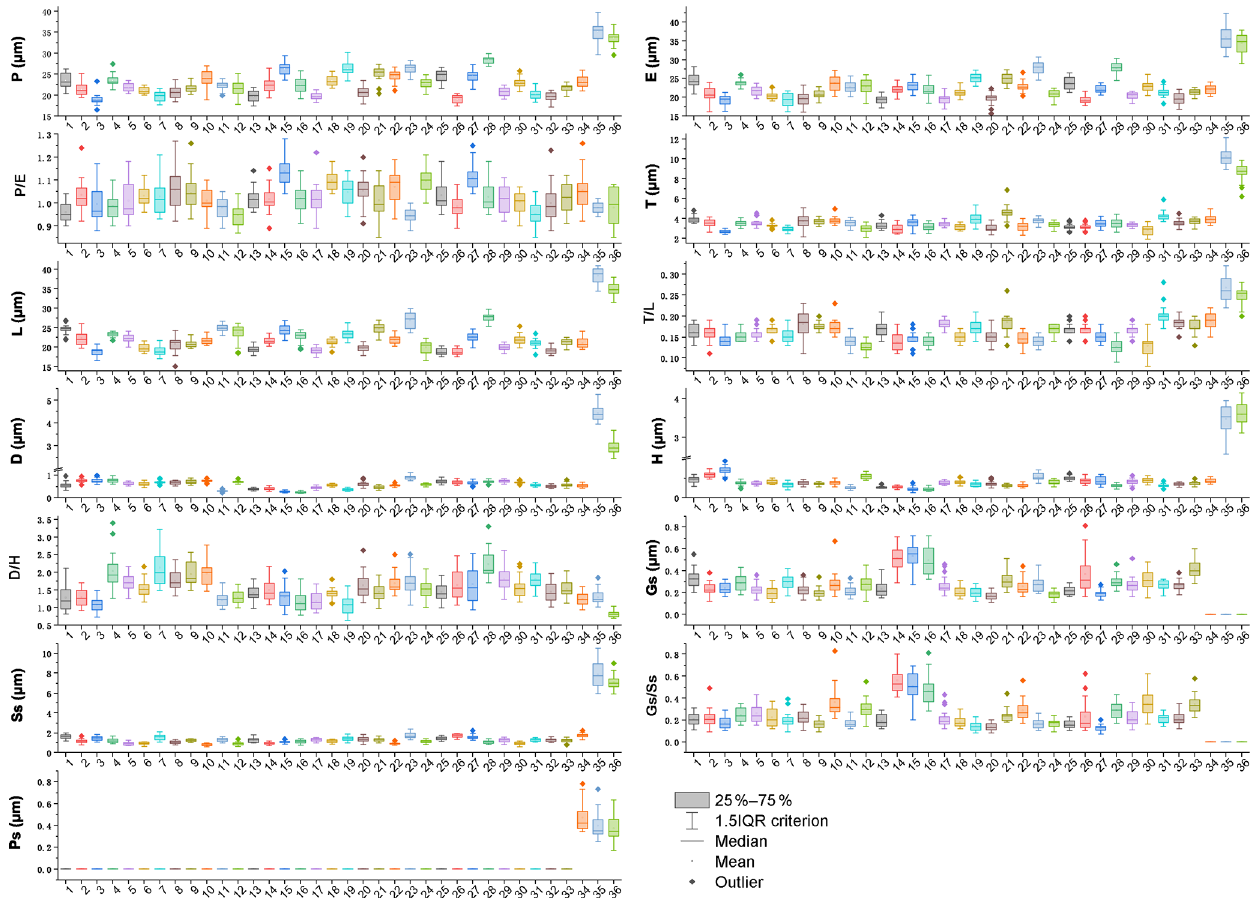
Figure 15. Boxplots of 36 sampled taxa showing the variations in pollen morphological traits. 1. Artemisia cana ; 2. Artemisia tridentata ; 3. Artemisia californica ; 4. Artemisia indica ; 5. Artemisia argyi ; 6. Artemisia mongolica ; 7. Artemisia vulgaris ; 8. Artemisia selengensis ; 9. Artemisia ludoviciana ; 10. Artemisia roxburghiana ; 11. Artemisia rutifolia ; 12. Artemisia chinensis ; 13. Artemisia kurramensis ; 14. Artemisia compactum ; 15. Artemisia maritima; 16. Artemisia aralensis ; 17. Artemisia annua ; 18. Artemisia freyniana ; 19. Artemisia stechmanniana ; 20. Artemisia pontica ; 21. Artemisia frigida ; 22. Artemisia rupestris ; 23. Artemisia sericea ; 24. Artemisia absinthium ; 25. Artemisia abrotanum ; 26. Artemisia blepharolepis ; 27. Artemisia norvegica ; 28. Artemisia tanacetifolia ; 29. Artemisia tournefortiana ; 30. Artemisia dracunculus ; 31. Artemisia japonica ; 32. Artemisia capillaris ; 33. Artemisia campestris ; 34. Kaschagaria brachanthemoides ; 35. Ajania pallasiana ; 36. Chrysanthemum indicum